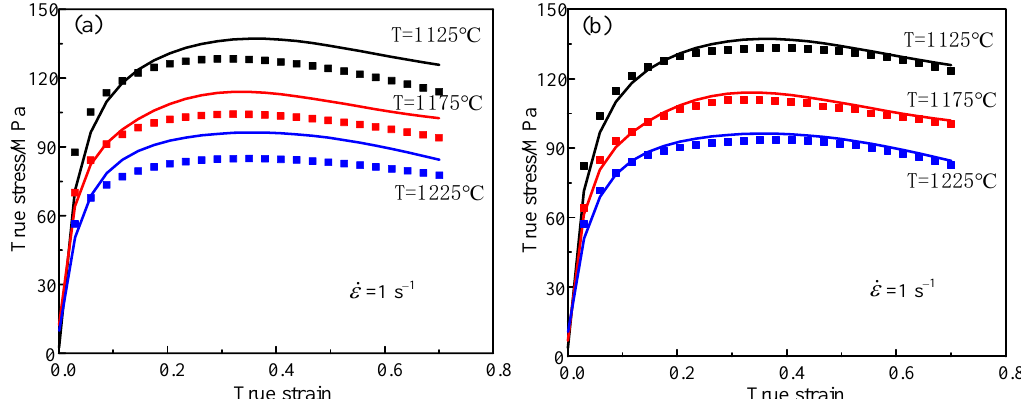
Figure 13. Comparative plots for the experimental results (lines) and fitted values of constructed model under different solution methods: ( a ) traditional calibration method, ( b ) adaptive simulated annealing optimization method.